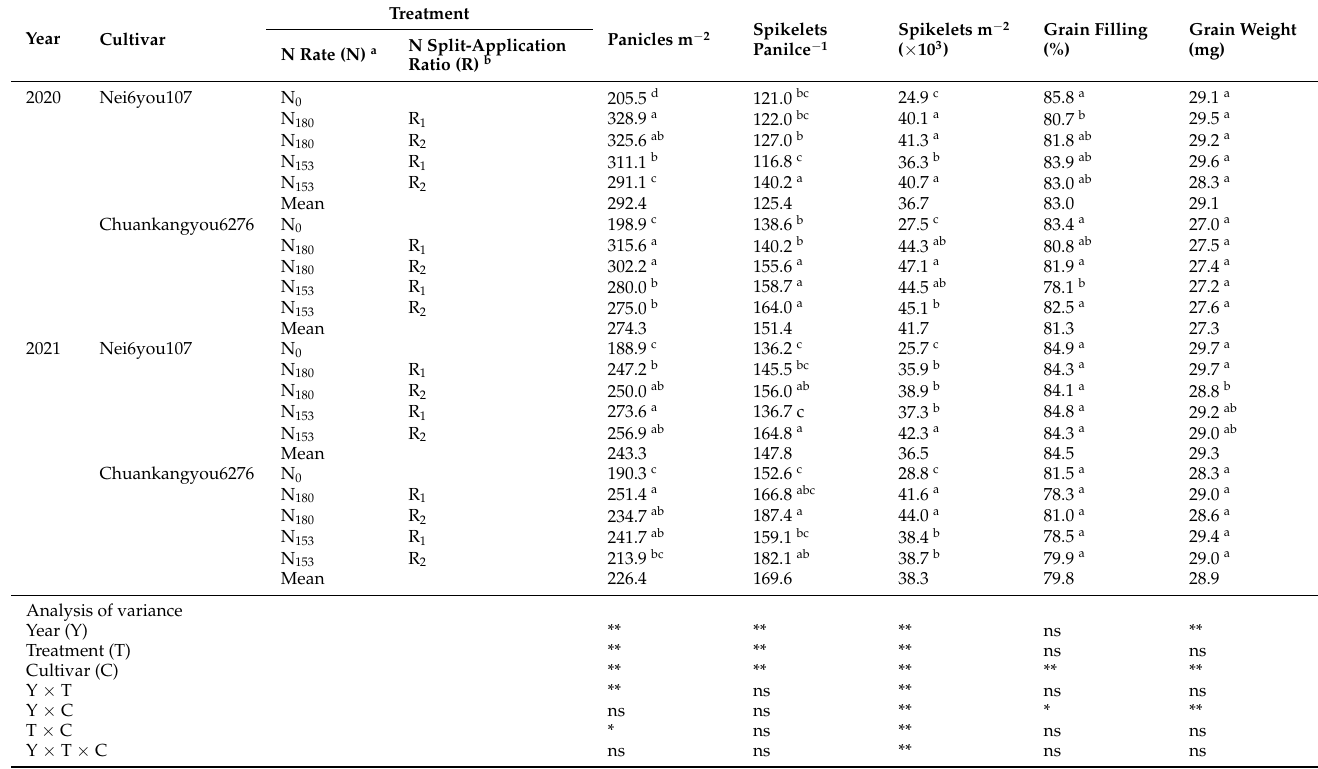
Table 3. Effects of different N management practices on yield components of hybrid rice grown in the no-tillage, direct-seeded (NTDS)